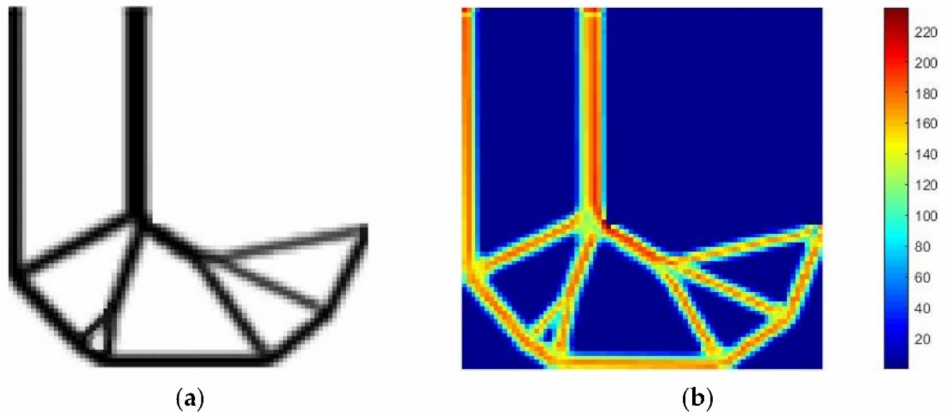
Figure 10. Reliability topology optimization result of L-beam structure (6400 elements): ( a ) Topologi- cal structure; ( b ) Von Mises stress